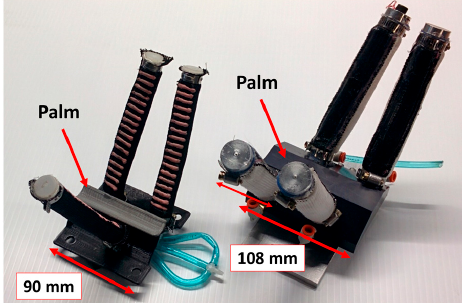
Figure 3. Assembled grippers. Left : Small; Right : Large.